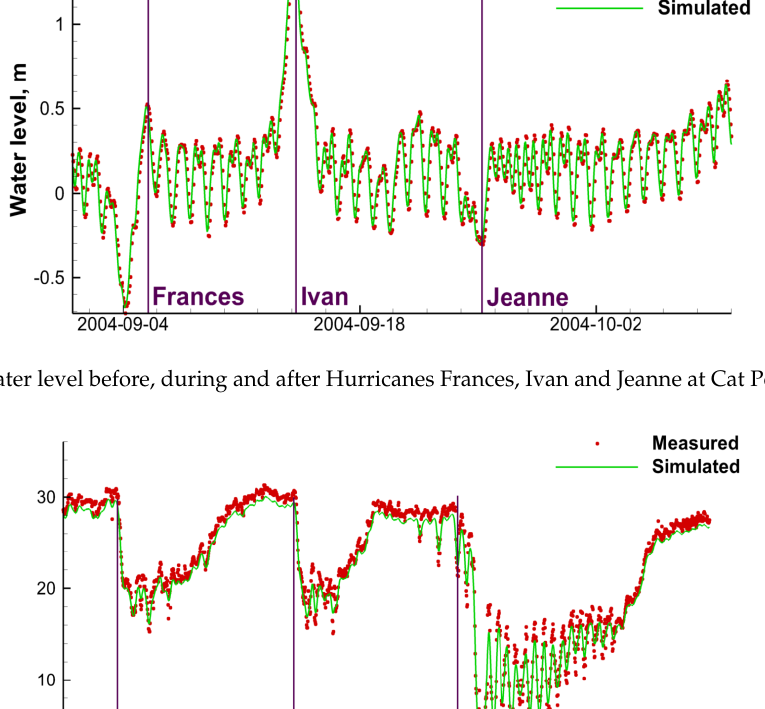
Figure 4. Simulated salinity at ( a ) Cat Point; and ( b ) Dry Bar stations during 2004.